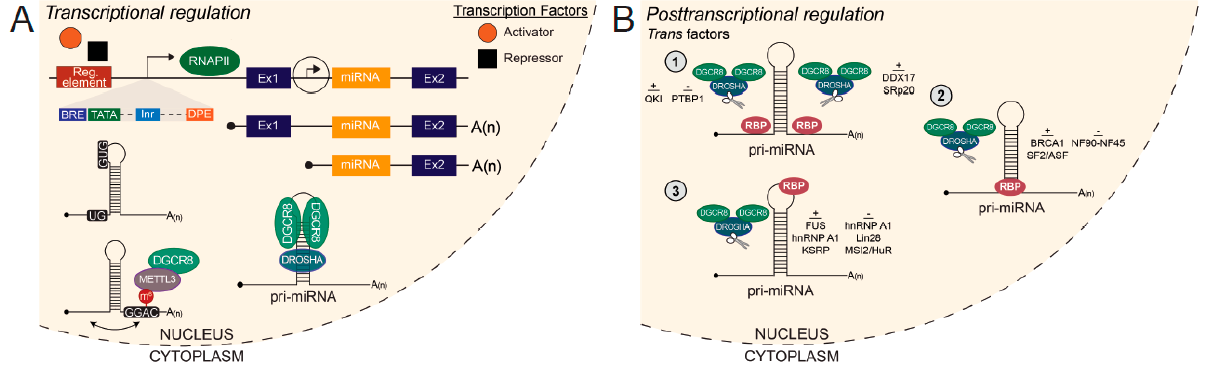
Figure 1. Transcriptional and posttranscriptional regulation of miRNA biogenesis. ( A ) RNA polymerase II (RNAPII)- mediated transcription of a miRNA host gene from an upstream host gene promoter or independent transcription start site produces two variant pri-miRNAs. Transcription factors bind to transcriptional regulatory elements proximal to the transcription start site (TSS) to activate or repress gene expression. At the TSS, miRNA host gene promoters harbor the same features as eukaryotic protein-coding gene promoters. Cis elements, UG at the 5 ′ basal junction and UGUG/GUG in the apical loop, discriminate pri-miRNAs from other secondary structures in the transcriptome and recruit Microprocessor for cleavage. The methyltransferase METTL3 deposits m6A modifications on pri-miRNAs to enhance recognition by DiGeorge Syndrome Critical Region 8 (DGCR8). Drosha and DGCR8 bind the pri-miRNA as a heterotrimeric complex to cleave and generate a pre-miRNA for further downstream processing. ( B ) Trans acting factors known to bind pri-miRNAs that positively or negatively regulate Microprocessor cleavage. (1) Factors which bind to the single-stranded RNA flanking the stem-loop. Binding toward the 5 ′ or 3 ′ end of the pri-miRNA is specified. (2) Factors which bind to the stem-loop. (3) Factors which bind to the apical loop. Regulatory element, Reg. element; TFIIB recognition element, BRE; TATA box, TATA; Initiator, Inr; Downstream promoter element, DPE; RNA Polymerase II, RNAPII; Exon, Ex; Methyltransferase-like 3, METTL3.